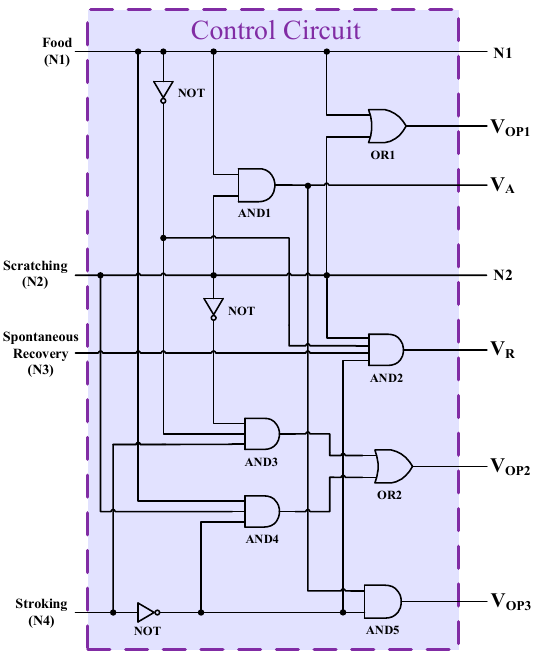
Figure 3. The schematic view of the proposed control circuit to feed synaptic network. Table 2 shows the truth table for all combinations that have been used in the work. Initially, all the stimuli are given separately and the responses of all the gates are recorded. Afterwards, combinations of more than one stimulus are considered and the responses of the logic gates are noted. It is worth mentioning that ( ↑ ) and ( ↓ ) are considered 1 and 0, respectively. Table 2. The truth table of the proposed control circuit. AND1 AND2 AND3 AND4